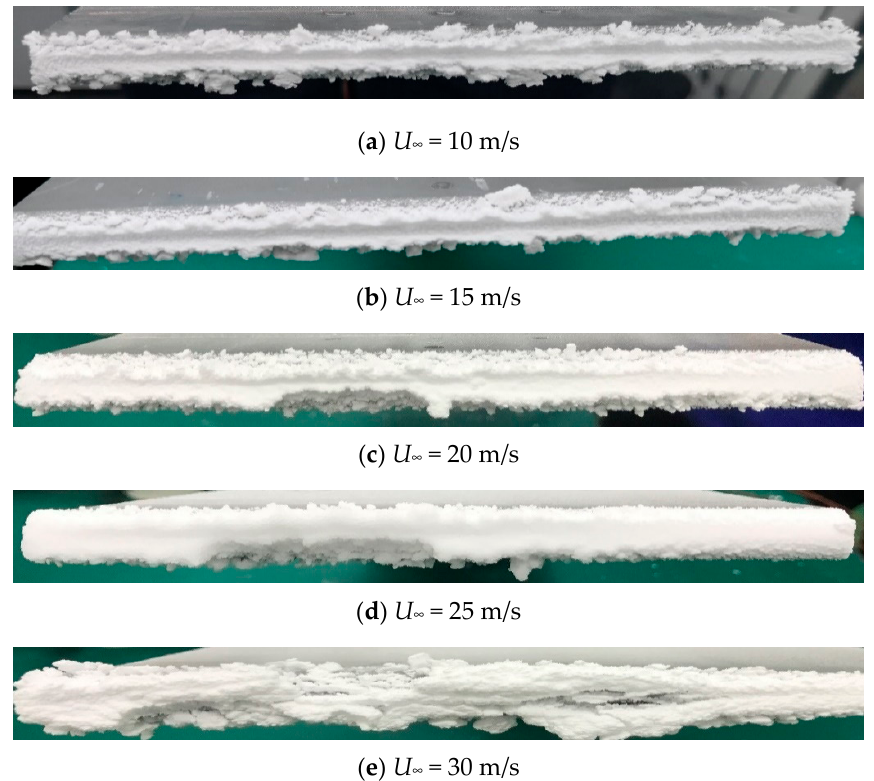
Figure 8. Photographs of wax deposition on leading edge with different mainstream velocities.